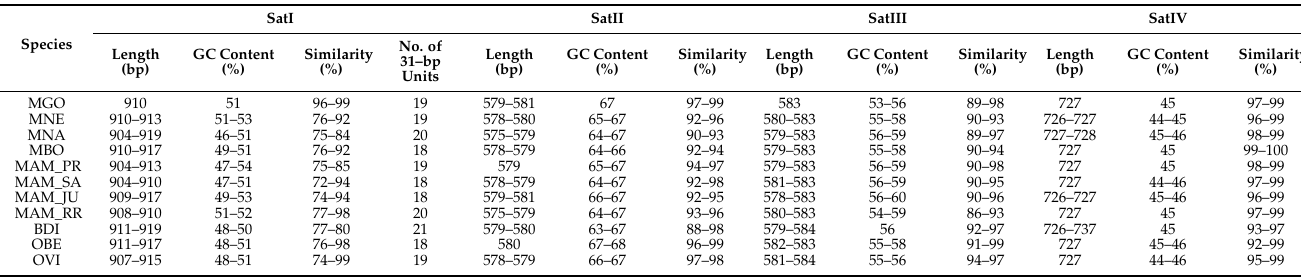
Table 2. Characteristics of the satI-IV sequences based on four clones of each satellite DNA analyzed in each sample of Neotropical deer (see text for abbreviations of species names).